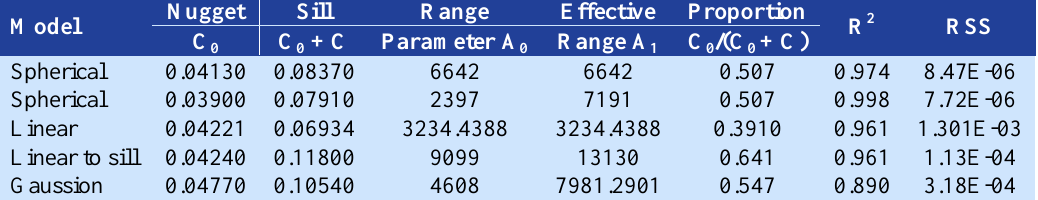
Table 2. Best-fitted variogram models of Langelier saturation index